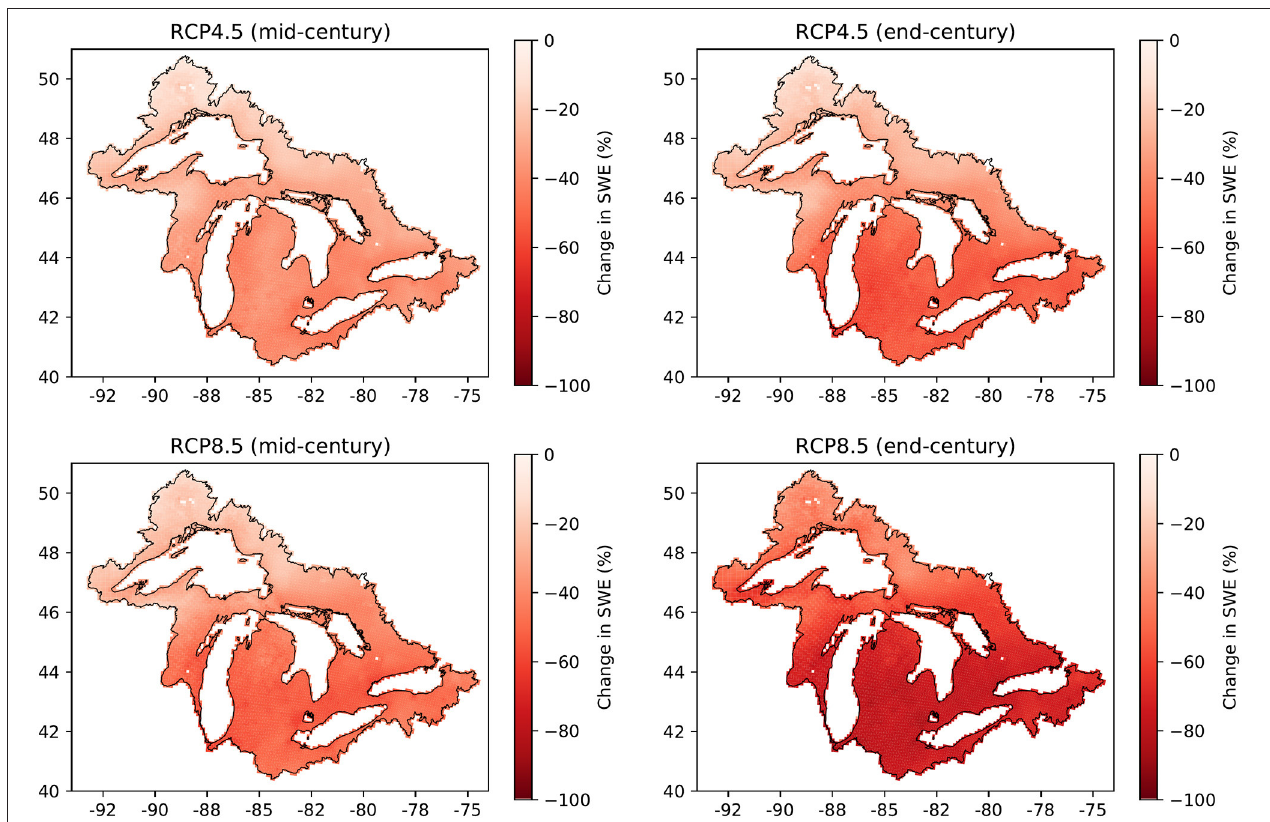
FIGURE 11 | Percentage change in annual mean snow water equivalent (SWE) of GL basin for RCP 4.5 and RCP 8.5 scenarios in both mid- and end-century